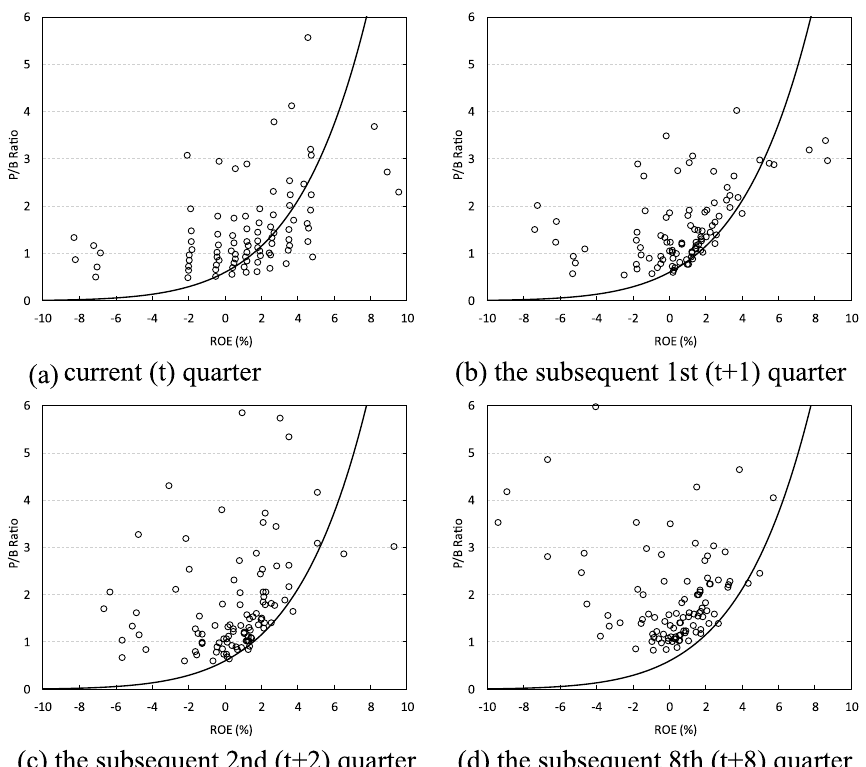
Fig. 14 ROE (X axis) and P/B (Y axis) in the current quarter and the subsequent 1st, 2nd, and 8th quarter after the portfolios are formed: Small market value